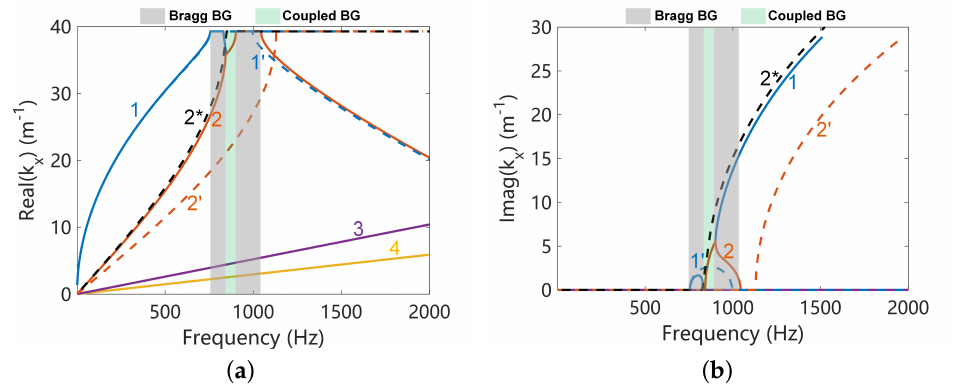
Figure 12. Dispersion curves along the x direction of L-network with L = 0.2 H, ( a ) shows the real part of k x and ( b ) shows the imaginary part. Waves 1 and 2 are electromechanical waves. The dash lines 1’ and 2* refer to uncoupled disconnected flexural and electric waves respectively. The dash line 2’ refers to the uncoupled blocked electric